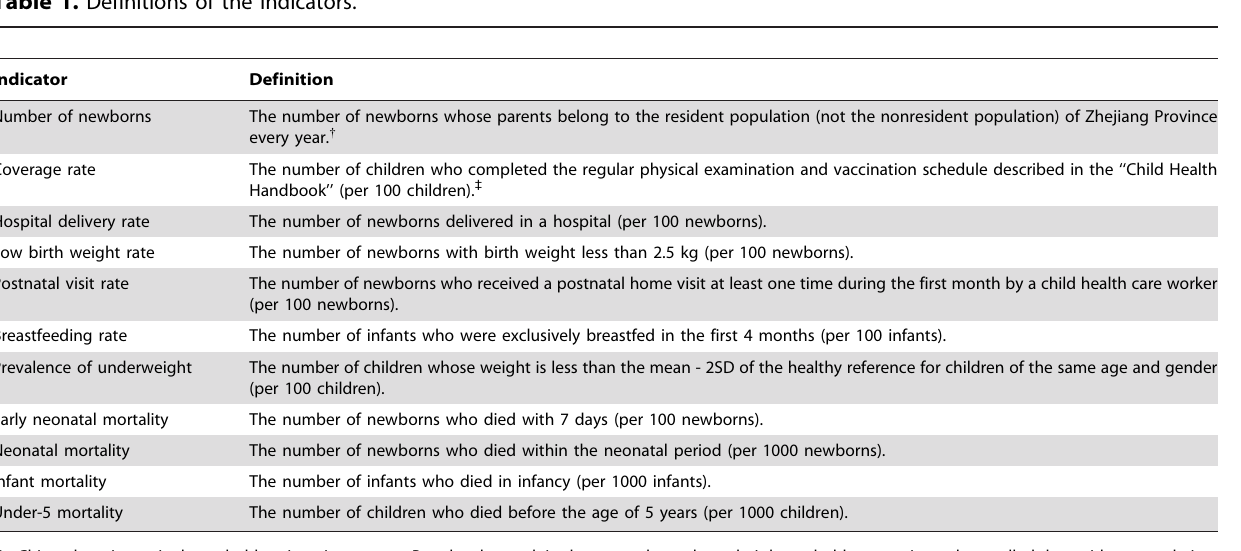
Table 1. Definitions of the indicators.